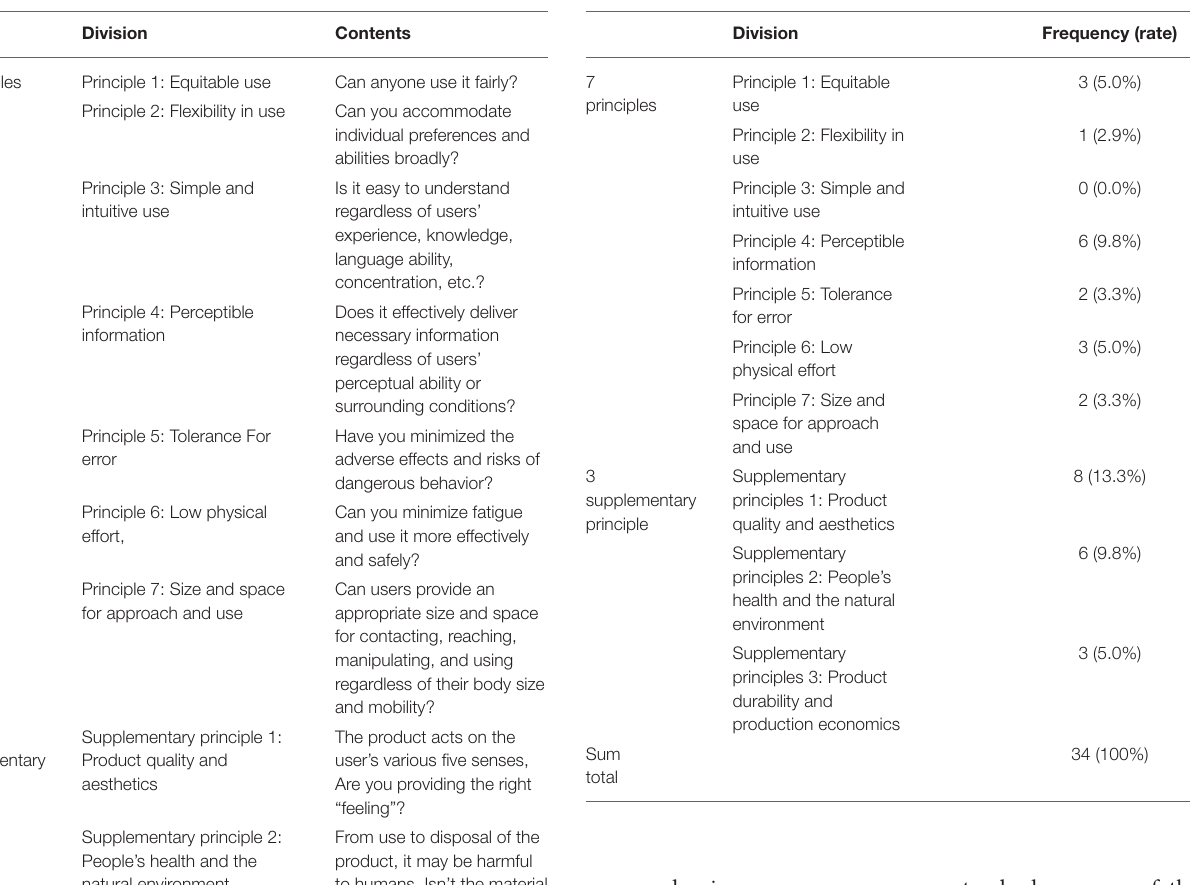
TABLE 3 | UD application in the scope of evaluation